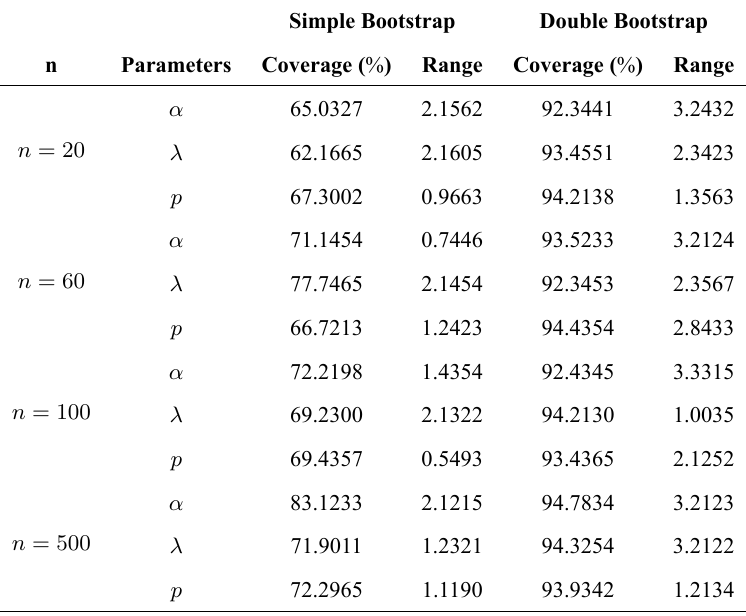
Coverage and range of interval estimates by simple bootstrap, double and nominal level of 95%. Simple Bootstrap